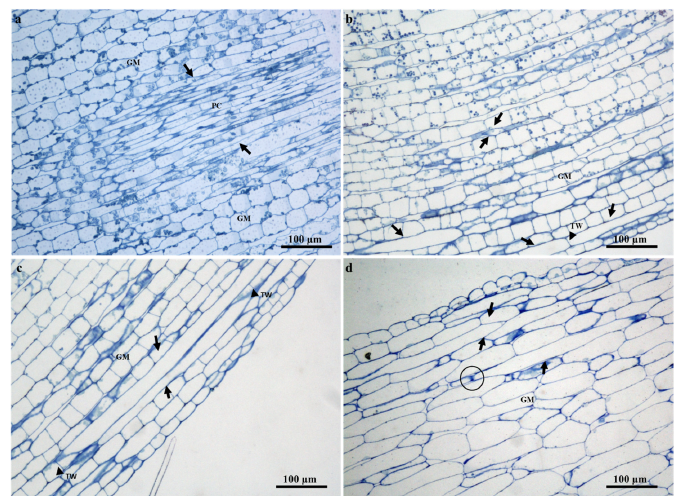
Figure 3. Light-micrographs showing the anatomy of laticifers in the seedling stem of T. ventricosa . ( a ) A longitudinal section through a seedling stem displaying the occurrence of articulated anastomosing laticifers. ( b ) A longitudinal section through the stem of a seedling depicts the arrangement of articulated laticifers closely associated with the epidermal tissue. ( c ) A transverse section through the seedling stem displaying an elongated-tapered syncytia cell, with terminal walls at the lateral ends. ( d ) A transverse section through the seedling stem showing the arrangement of overlapping laticifers. Note the cell wall dissolution of terminal walls at the tapered regions. Abbreviations: TW = terminal wall, GM = ground meristem, PC = procambium. Arrows refer to laticifers. Circle depicts cell wall dissolution. Plants 2020 , 9 , x FOR PEER REVIEW